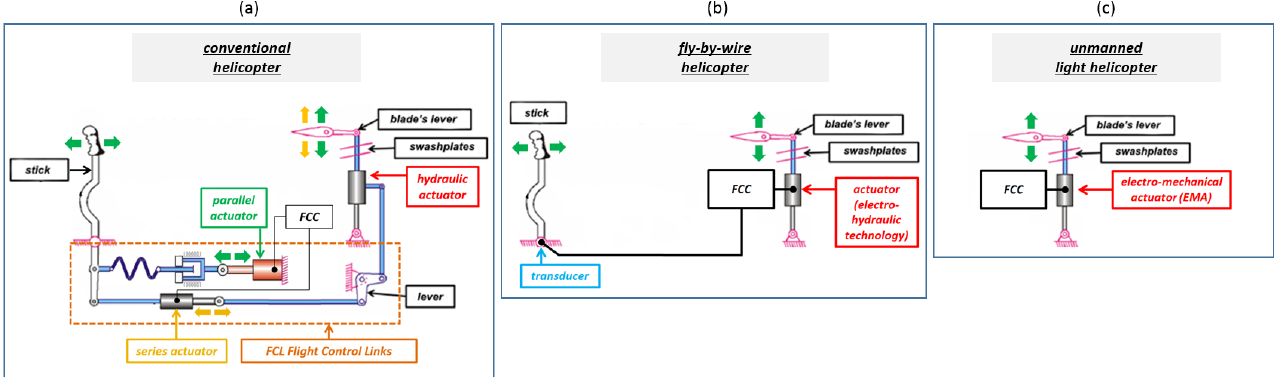
Figure 2. PFCS architectures: sketch of principle. From ( a – c ), this figure shows basically the evolution of PFCS architectures as it applies to autonomous helicopters. This evolution clearly shows that the helicopter mass can be significantly reduced with the reduction in part numbers. As long as the actuation control loop is concerned, this part number reduction decreases the response delay sources. The quid pro quo for it is the increase in the actuator critical level because it gathers nearly all piloting